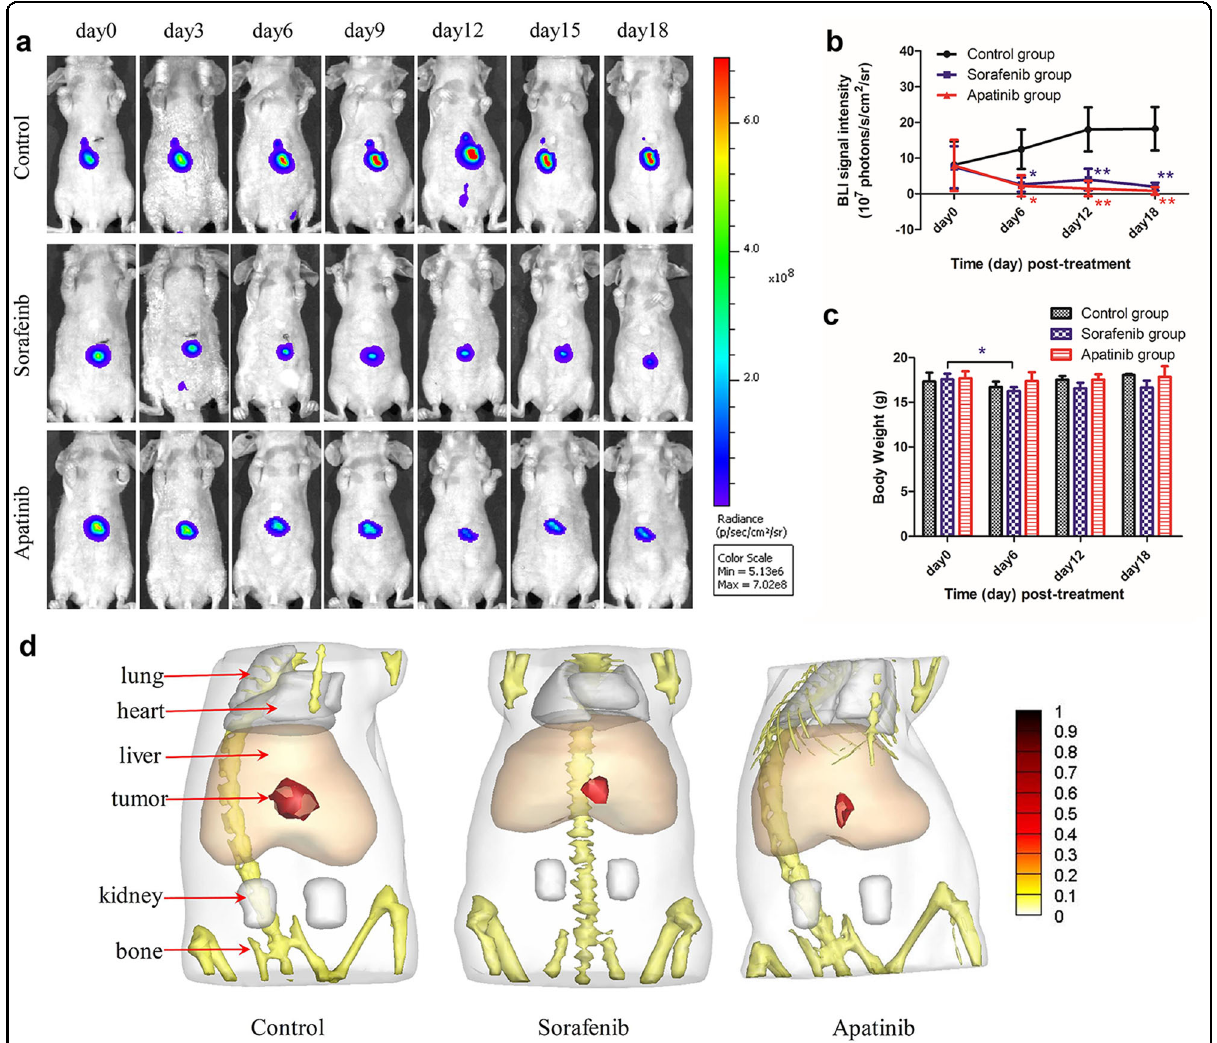
Fig. 3 BLI images and 3D BLT reconstruction of orthotopic liver tumors ( n = 5). a BLI signals of orthotopic HepG2-Red-fLuc cell-derived tumor- bearing mice on days 0, 3, 6, 9, 12, 15, and 18 post-drug treatment. b BLI signal intensity of mice. (*) P < 0.05, (**) P < 0.01 vs. the control group. c Body weight of mice. (*) P < 0.05, day 6 vs. day 0 in the sorafenib group. d The 3D BLT reconstruction in the control and sorafenib and apatinib treatment groups on day 20 post-drug